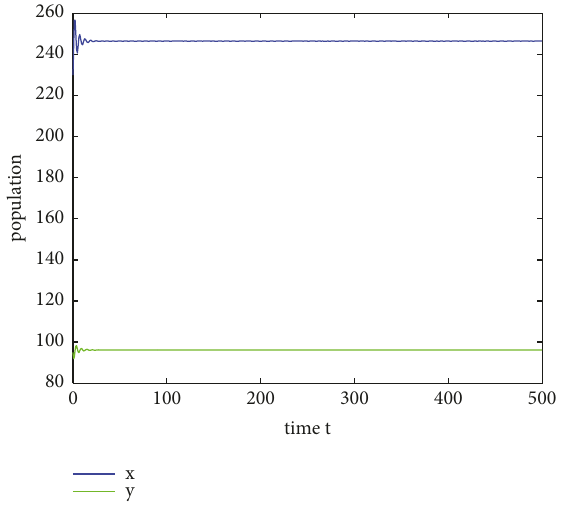
Figure 10: A Time series diagram for prey and predator. The figure depicts local stability of the interior equilibrium for the delayed model (3) with the time delays 𝜏 1 = 0 and 𝜏 2 = 0.1 , where the other parameter values are 𝑥(0) = 230 , 𝑦(0) = 95 , 𝐴 = 0.01 , 𝑟 = 2.65 , 𝐾 = 900 , 𝑎 = 0.02 , 𝑐 = 0.215 , and 𝑚 = 1.06 .